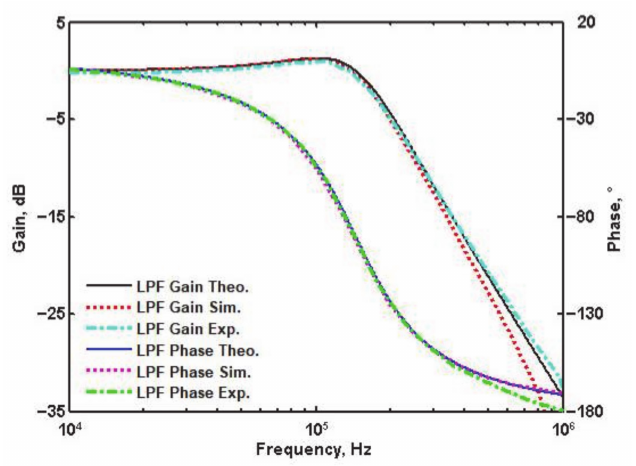
Figure 9. Comparison of LPF experimental response, simulated response, and theoretical response in Part II.